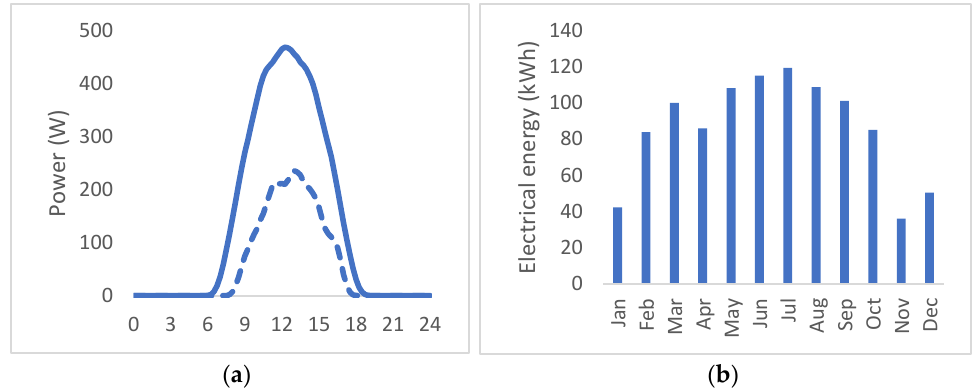
Figure 3. ( a ) Power production profiles of a PV module during a summer day and a winter day; ( b ) monthly energy production of the PV module.